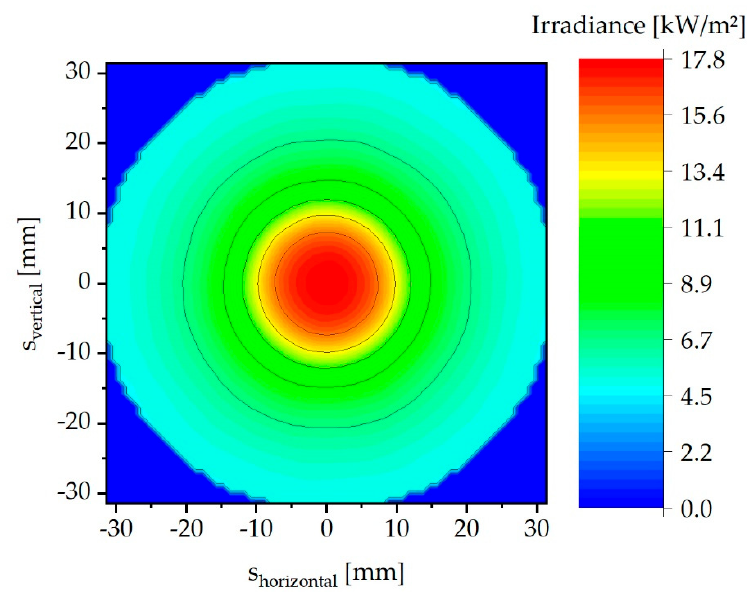
Figure 6. Exemplary irradiance distribution on the sample chamber ground in false colors at a current of 1.296 A.